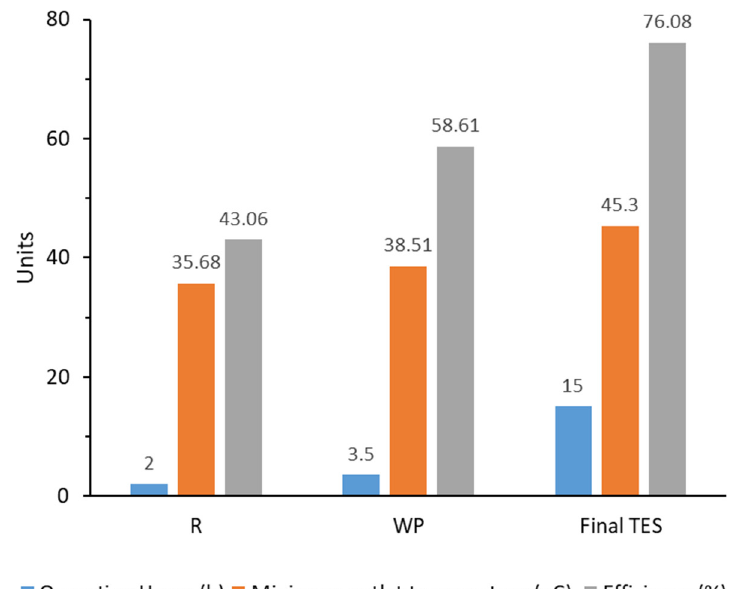
Figure 9. Comparison between performance parameters evaluated in step 1 (R) and step 4 (Final TES) in the redesign method [50].